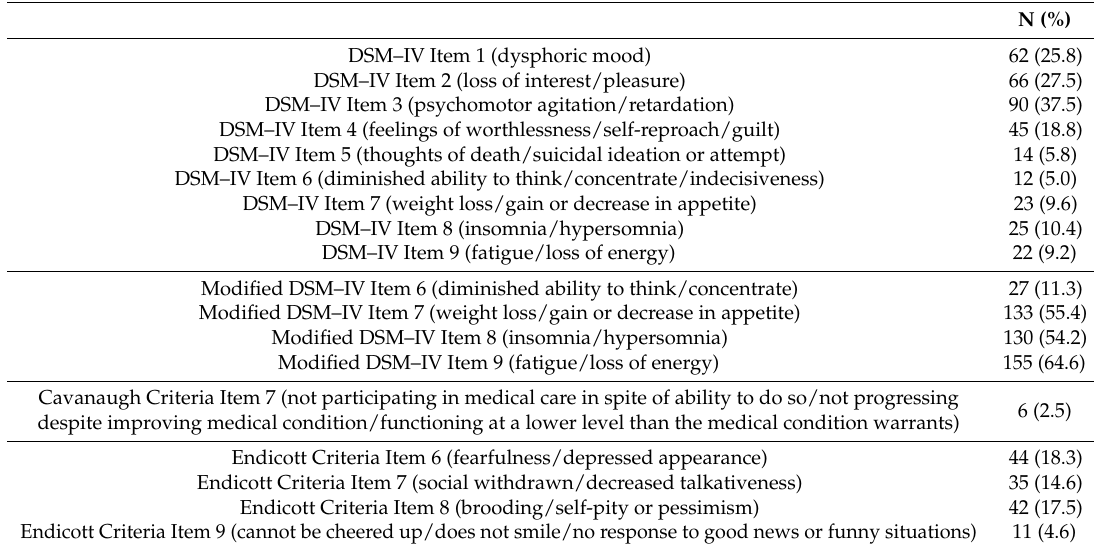
Table 2. Frequency of each item in the four different diagnostic criteria.